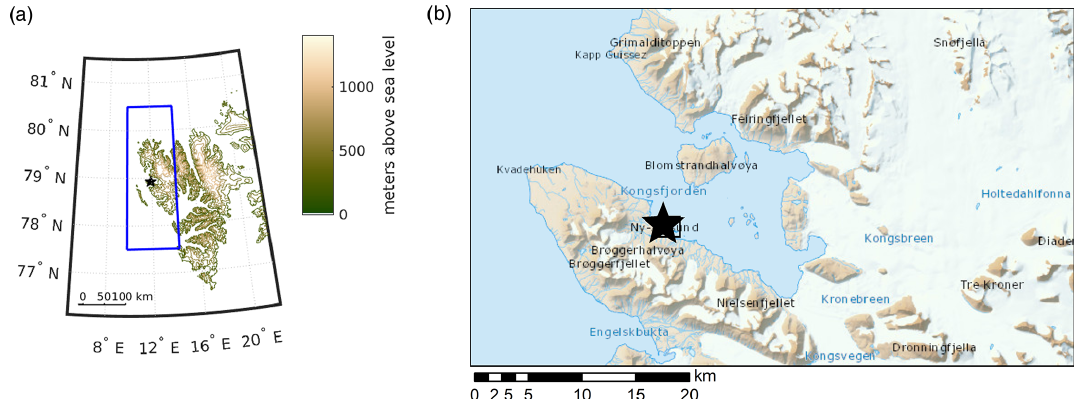
Figure 1. Topography map for Svalbard (a) and a detailed illustration of the Kongsfjorden area (b) . The black star indicates the location of Ny-Ålesund, where the measurements are taken. The domain covered by the circulation weather type (see Sect. 3.3) is shown by the blue rectangle. Topography data by Amante and Eakins (2009) (a) and the Norwegian Polar Institute (2014) (b) .